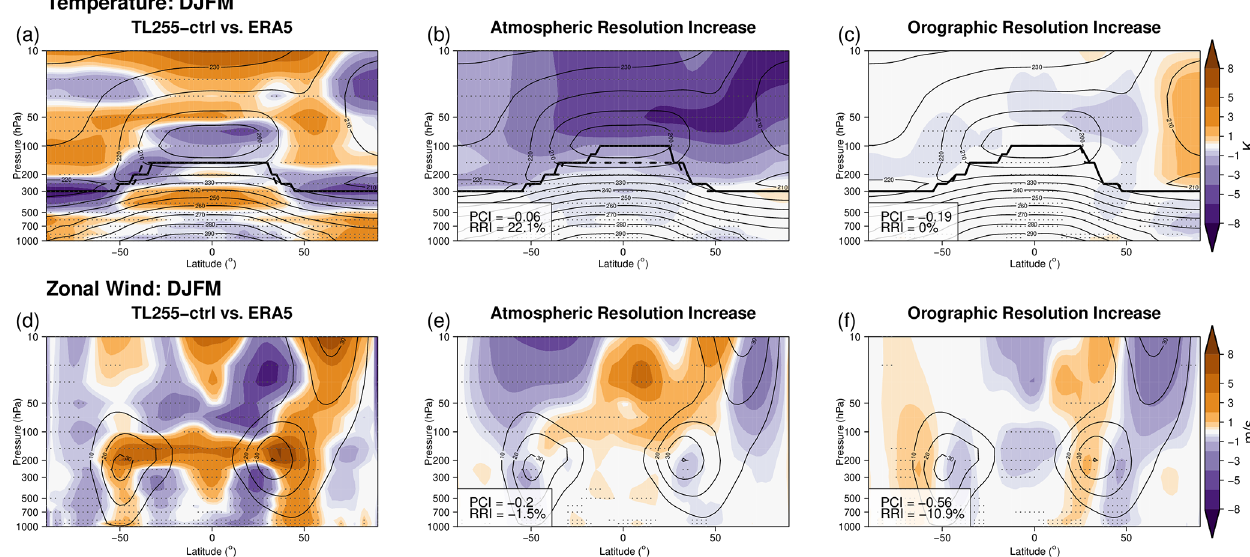
Figure 1. DJFM zonal mean temperature (a–c) and zonal wind (d–f) : (a, d) EC-Earth3 TL255-ctrl bias with respect to ERA5, (b, e) changes induced by the atmospheric resolution increase and (c, f) changes induced by the orographic resolution increase. Shading shows differences and contours the TL255-ctrl field. Please note the irregular colour-bar spacing. In (a) – (c) black lines show the tropopause height for reference (dashed) and changes (solid). Stippling indicates significance with a Welch t test at the 1% level. In (b) , (c) , (e) and (f) the PCI and RRI (see text for details) are reported at the bottom left of each panel: large negative values imply reduced